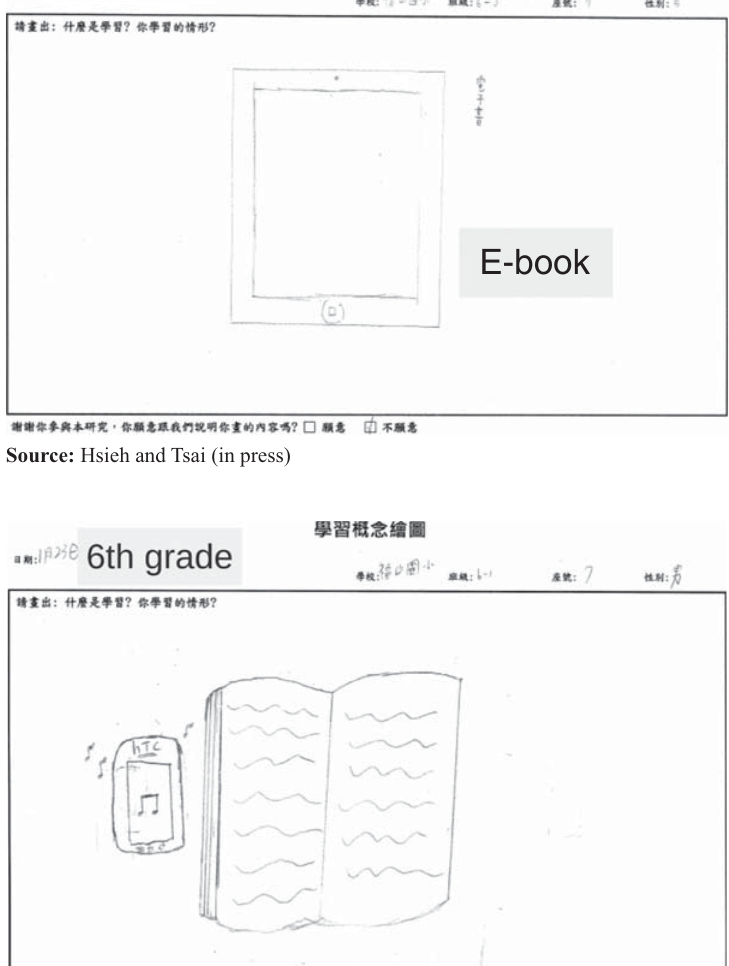
Figure 10. A drawing by a